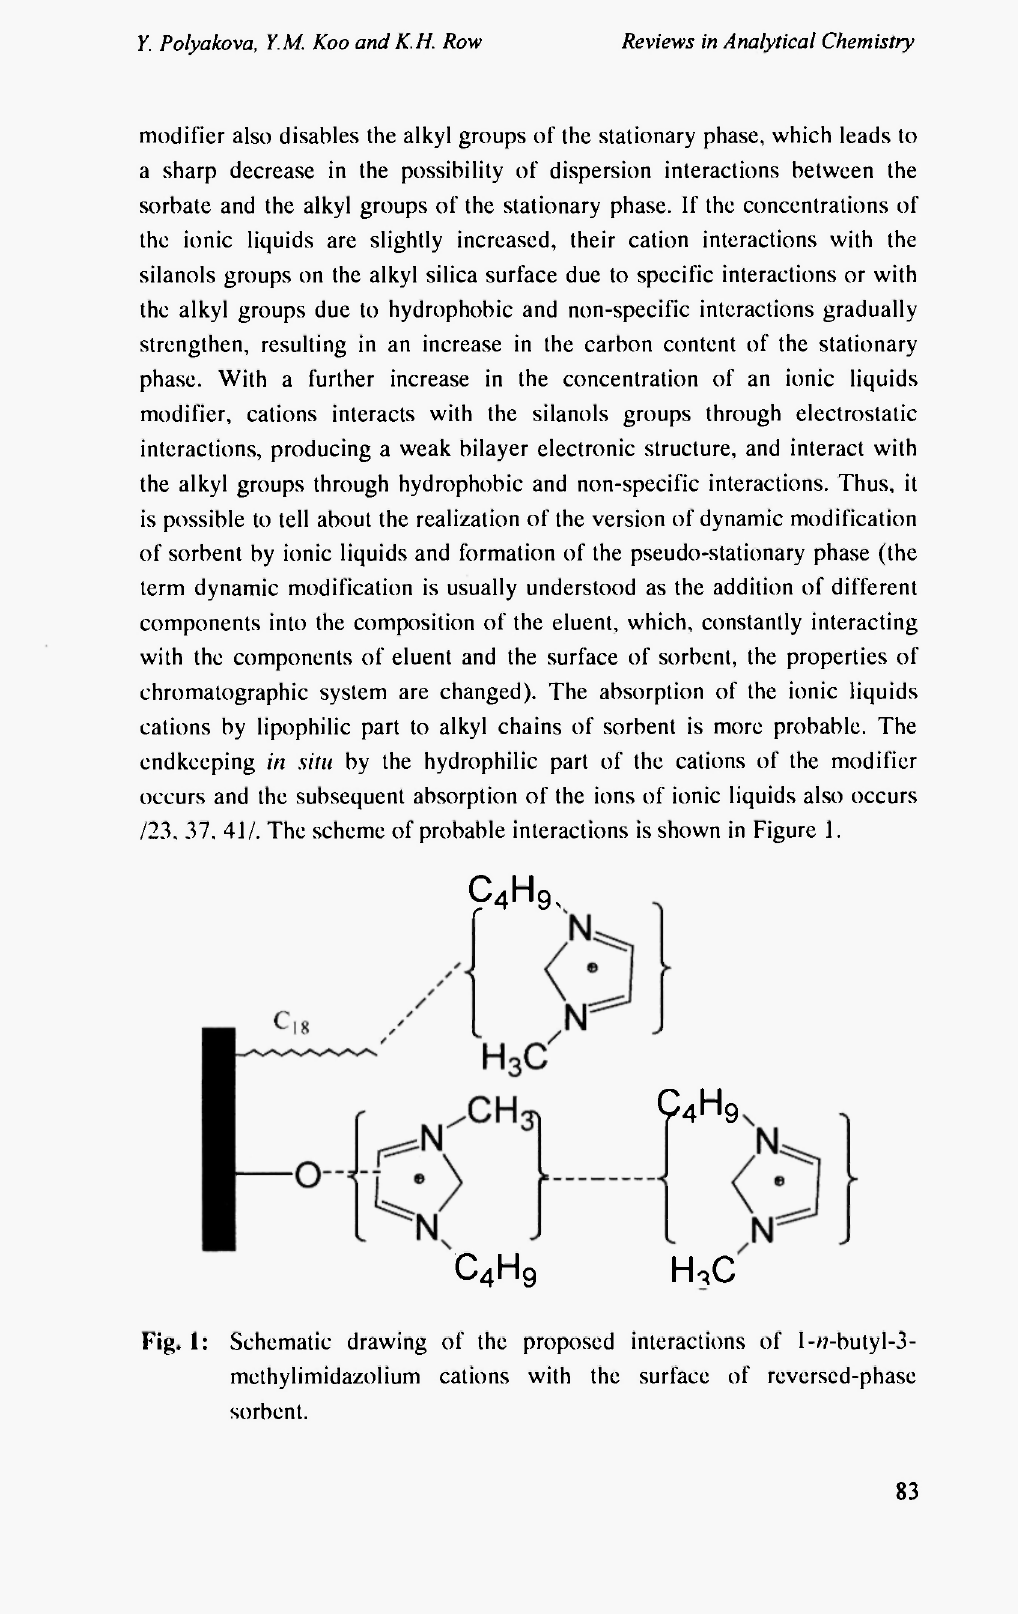
Fig. 1: Schematic drawing of the proposed interactions of I-/7-butyl-3- methylimidazolium cations with the surface of reverscd-phase